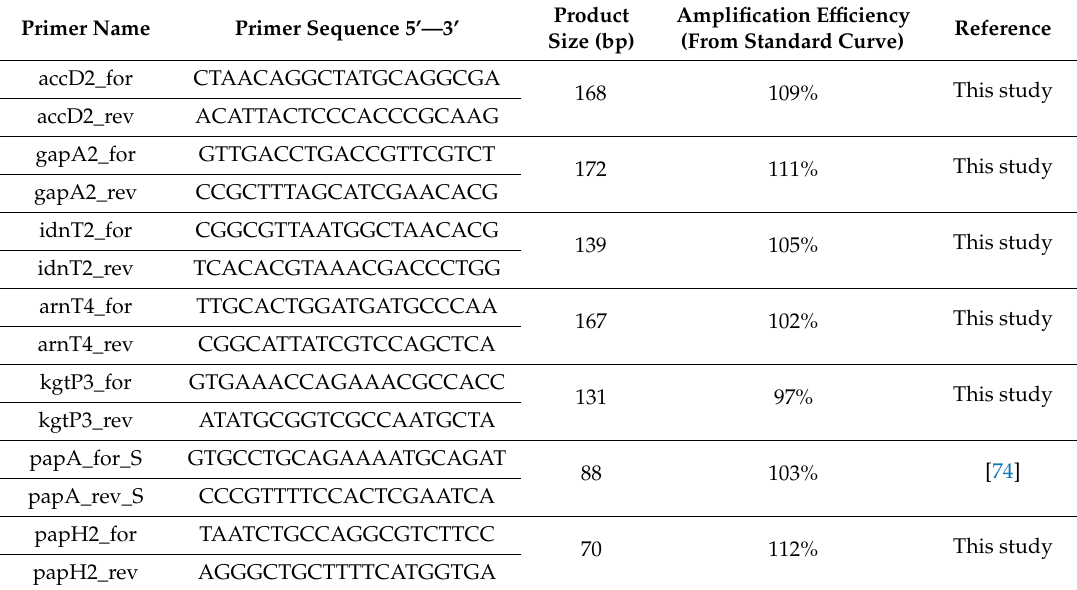
Table 7. Primers used in quantitative real time